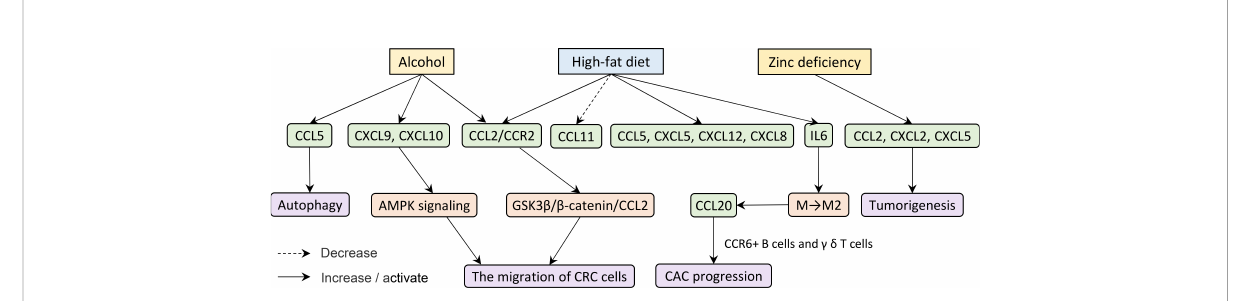
FIGURE 4 Excessive alcohol consumption and obesity have an effect on tumorigenesis and